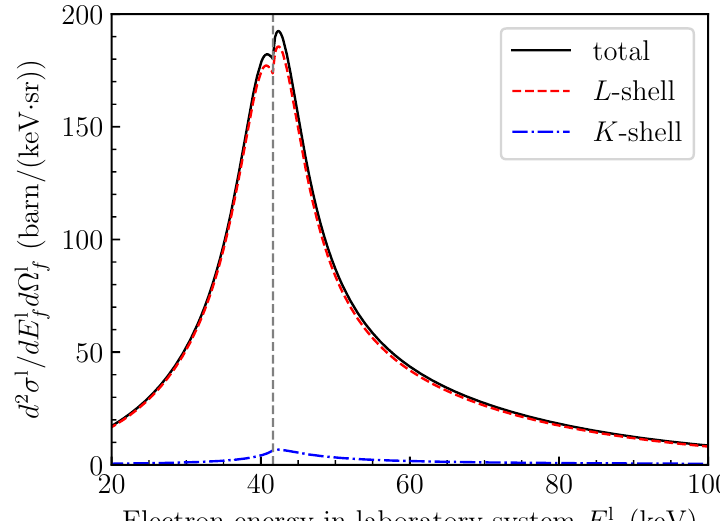
Figure 2. DDCS for ELC observed at θ l theory for total ELC with different maximum spectrometer acceptance angle θ max . The vertical line at = 41.64 keV corresponds to the cusp. E l f